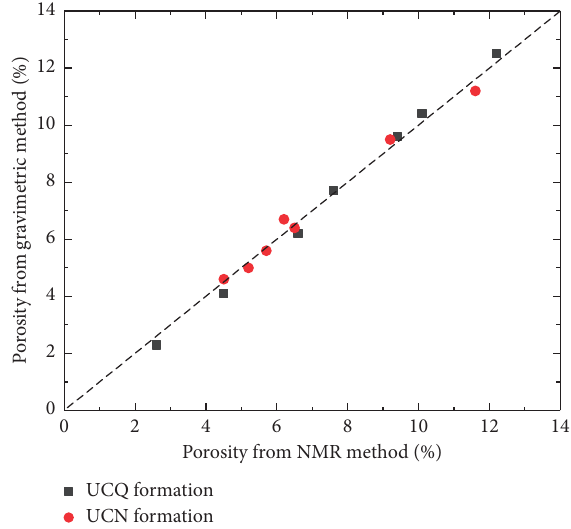
Figure 7: Comparison of porosity values from NMR and gravi- metric methods.